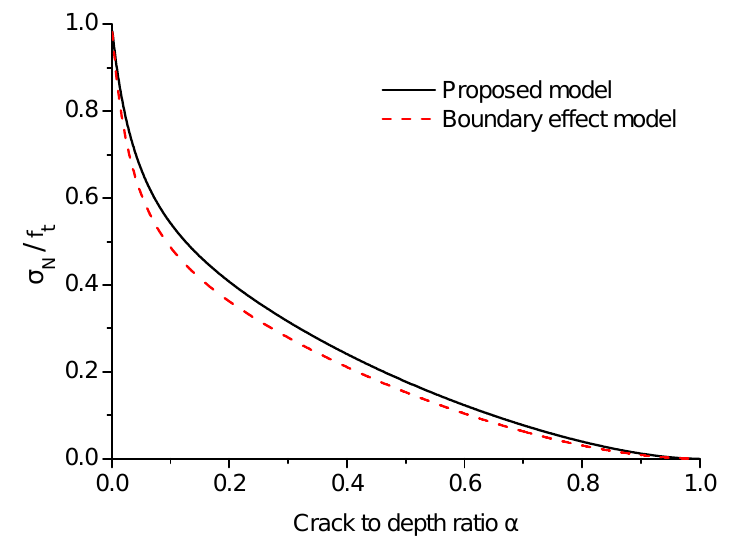
Figure A3. The ratio of nominal strength predicted by BEM and the proposed model and tensile strength σ N / f t for various crack to height ratios.